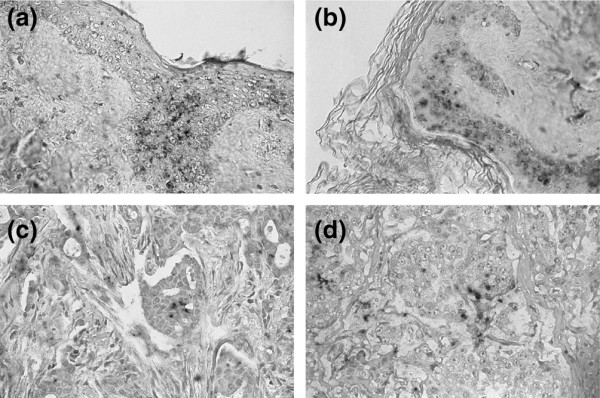
Papillomavirus sequences detected by in situ hybridisation. (a) Case 10012, in the nipple epithelium (magnification × 40). (b) Case 10041, in the nipple epithelium (magnification × 40). (c) Case 10012, in tumour tissue (magnification × 100). (d) Case 10014, in tumour tissue (magnification × 100).